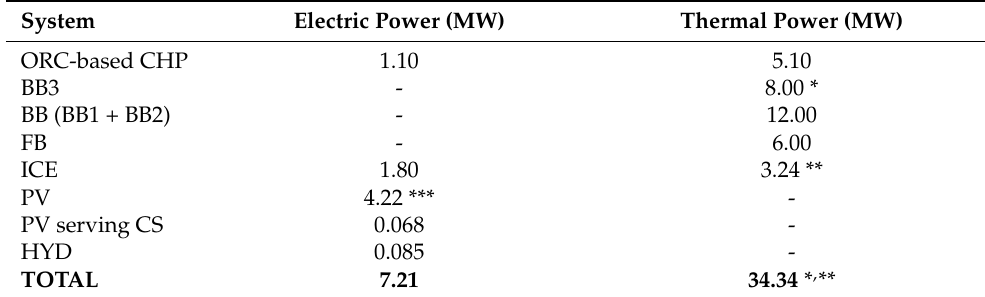
Table 2. Nominal and electric power of energy conversion systems.